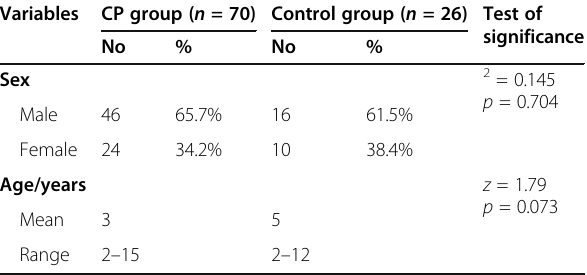
Table 1 Demographic characters of the studied cases Variables CP group ( n = 70) Control group ( n = 26) Test of